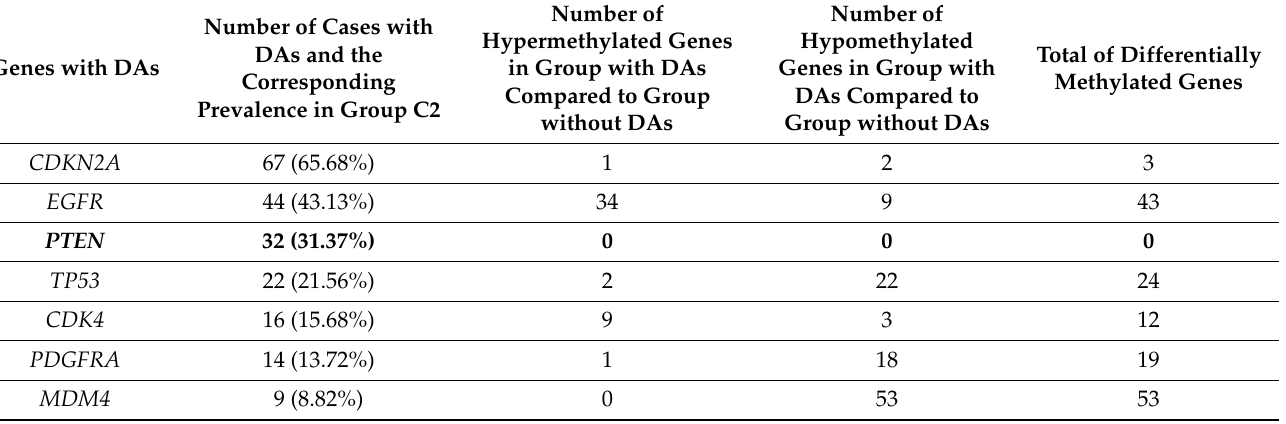
Table 3. Prevalence of cases with driver alterations in 12 common driver genes along with their associated counts of differentially methylated genes (hypermethylated, hypomethylated and total counts). The analyses were performed on C2